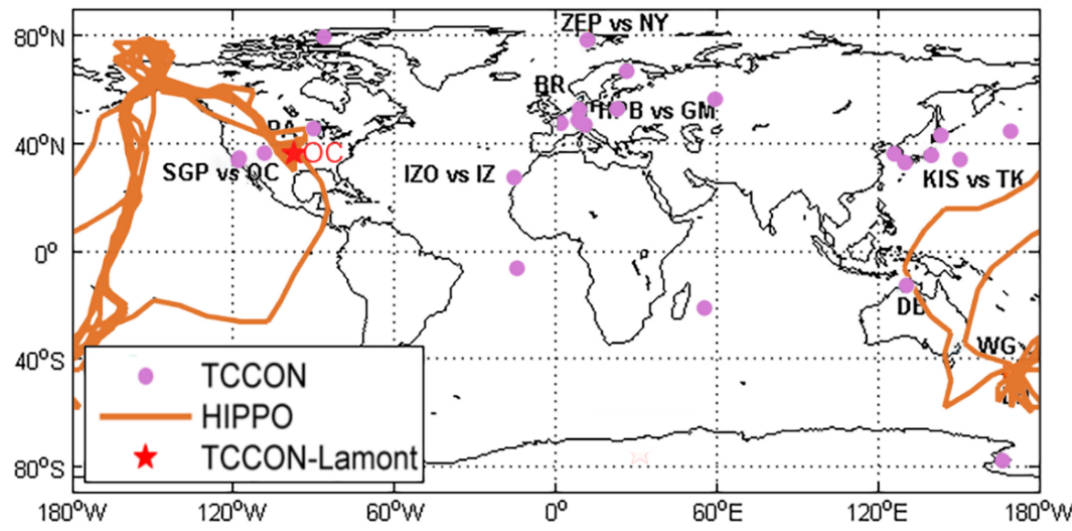
Figure 3. Overlay of TCCON site locations (purple dots) and HIPPO flight paths (orange lines).